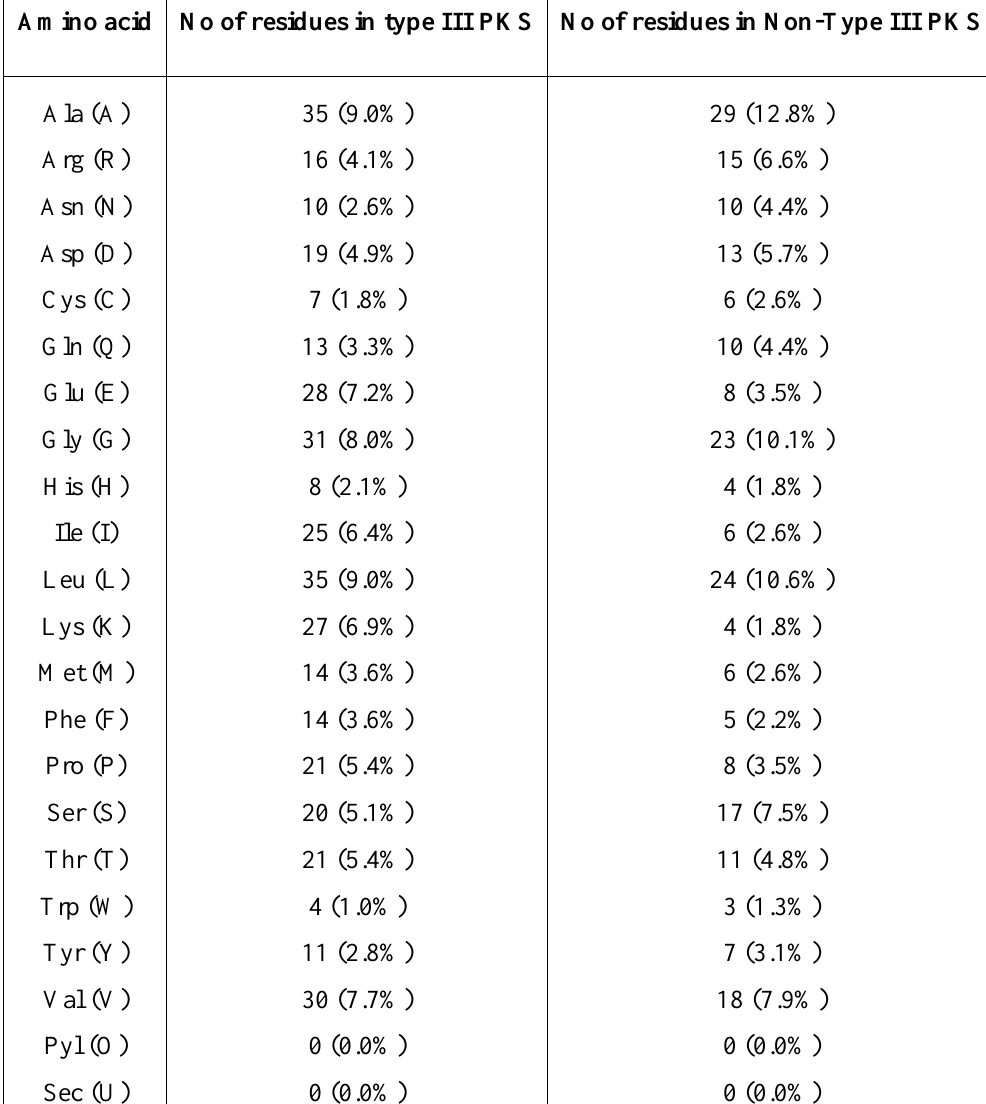
Table 1: Amino acid composition of type III PKS and non-Type III